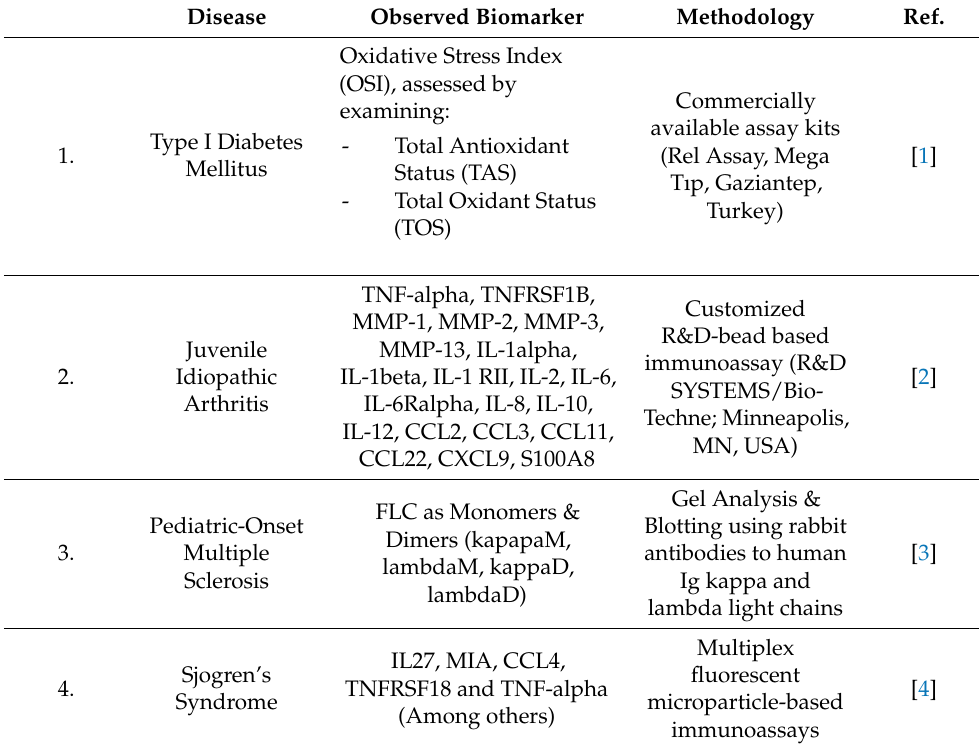
Table 1. Investigated autoimmune disorders and their respective